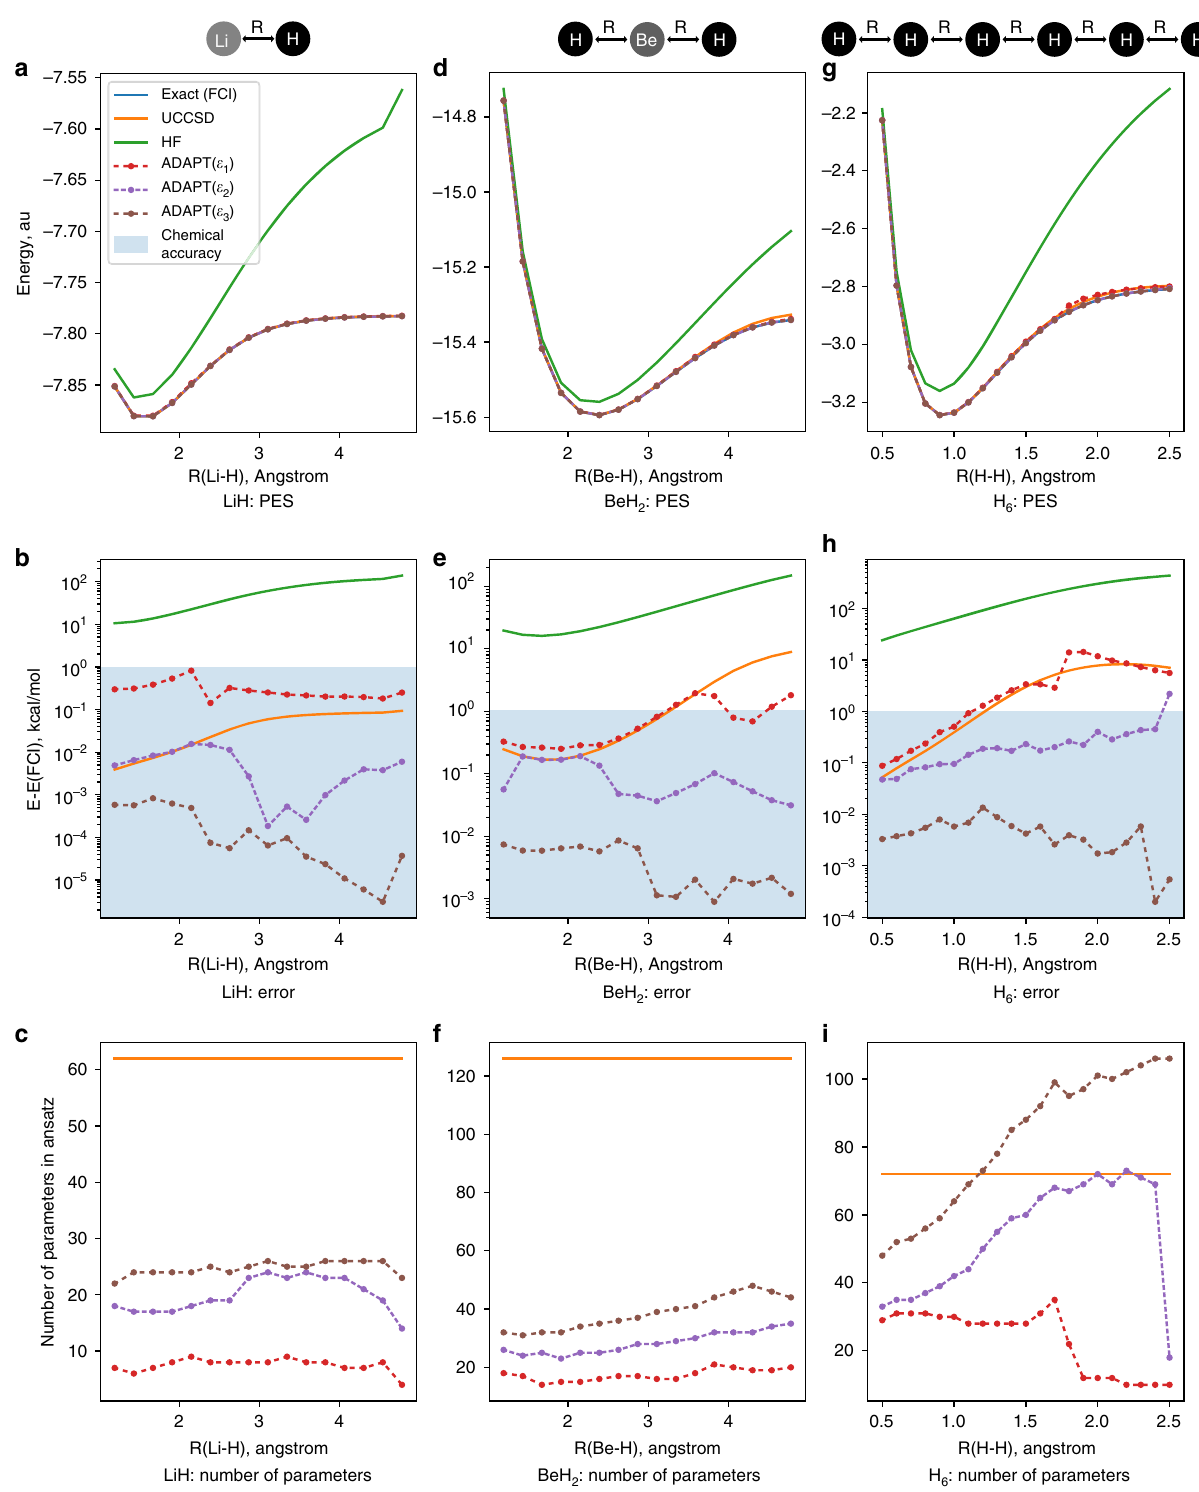
Fig. 2 Dissociation curves for LiH, BeH 2 , and H 6 . Potential energy as a function of nuclear coordinate, Hartree units ( a , d , g ). Absolute energy differences from FCI, kcal/mol units ( b , e , h ). Shaded blue region represents area within “ chemical accuracy ” as 1 kcal/mol. Number of variational operators in associated ansatz ( c , f , i ). Notation: ε indicates gradient norm threshold used such that ε m = 10 − m . In all curves, the FCI curve lies directly underneath the ADAPT( ε 3 ) curve, and so is not